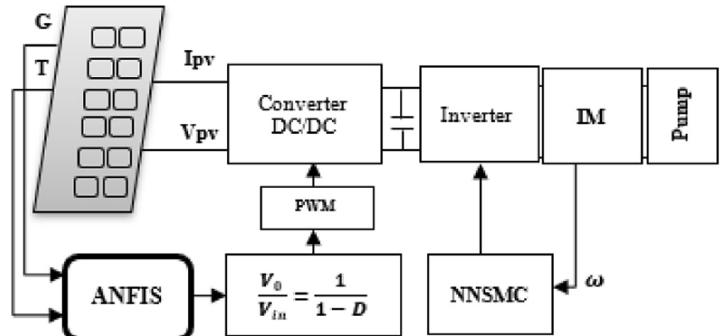
Fig. 1 Synoptic diagram of a pumping system